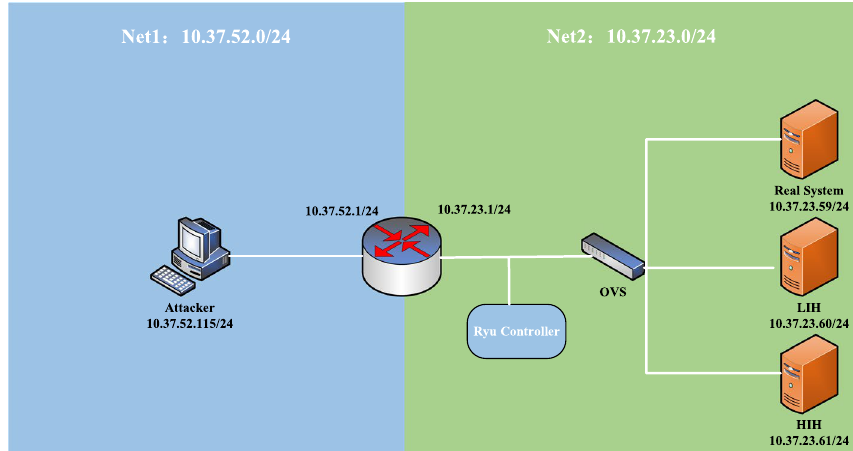
Fig. 7 Test environment